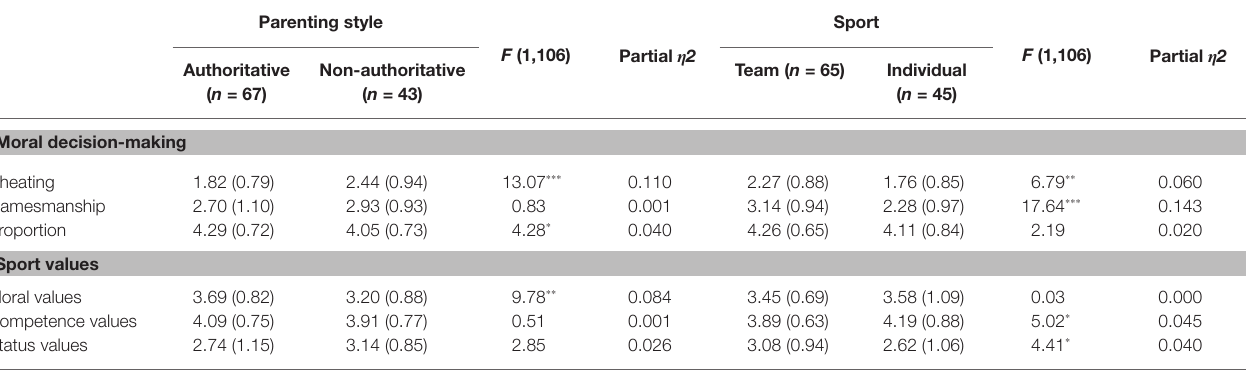
TABLE 2 | Means, SDs, and the results of multivariate ANOVA (MANOVA) analysis for the differences between youth’s moral decision making in sport and sport values by parenting style and sport type. Parenting